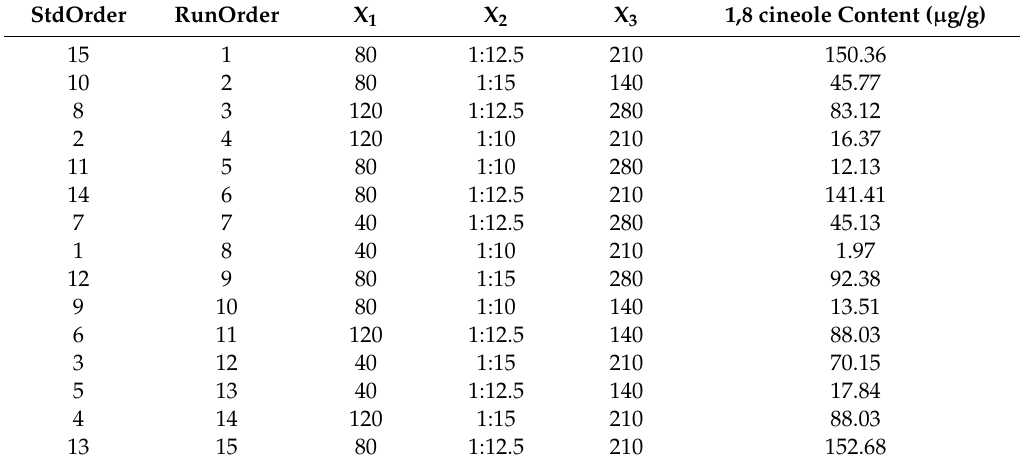
Table 4. Design program and results of response surface.